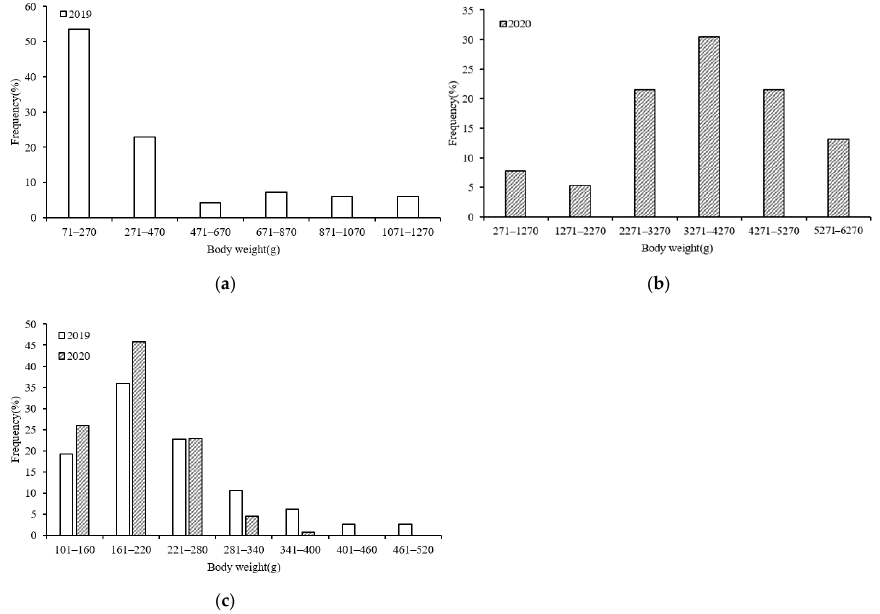
Figure 3. BW compositions of S. oualaniensis samples in different years: ( a , b ) female; ( c ) male.